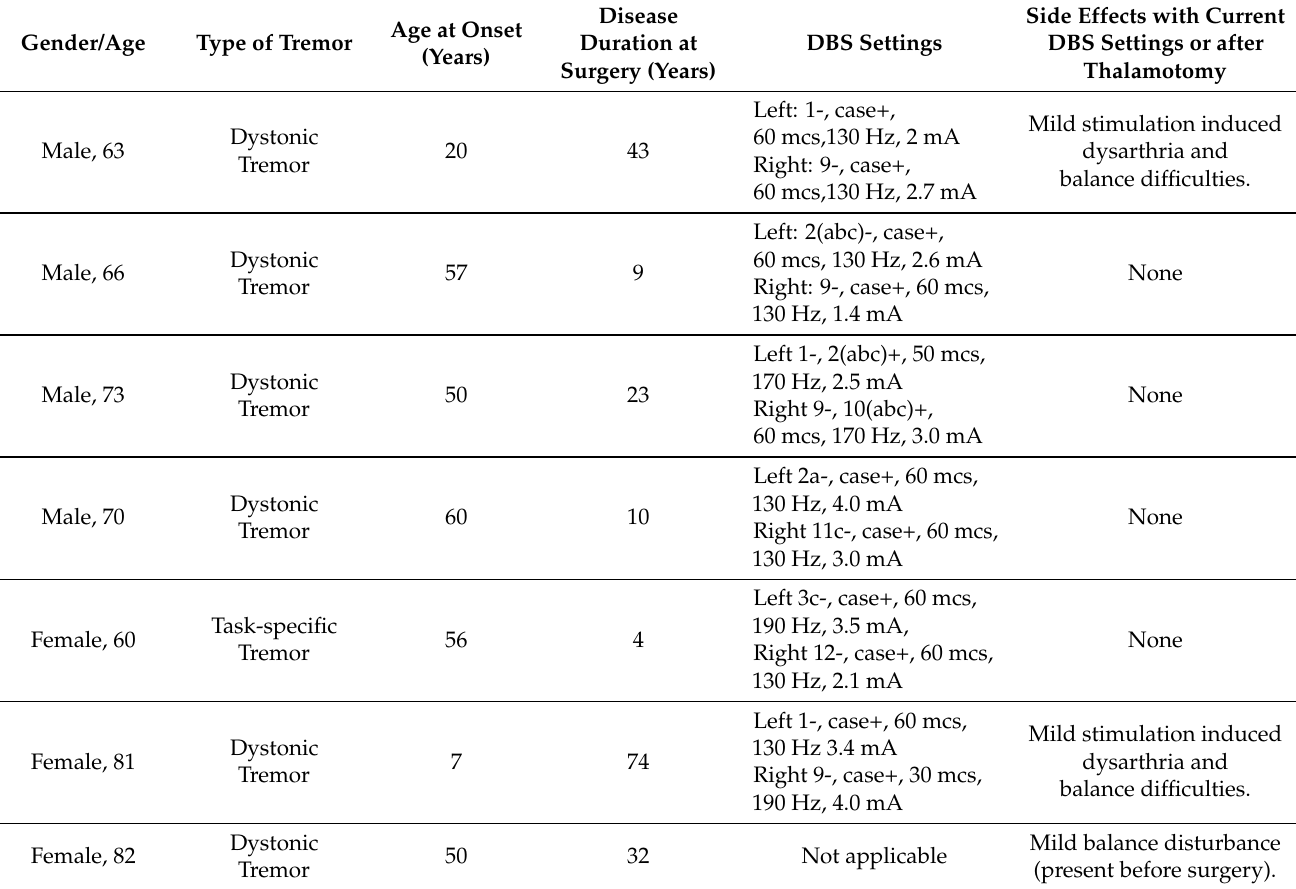
Table 3. Subjects with dystonic tremor and task-specific tremor treated with functional